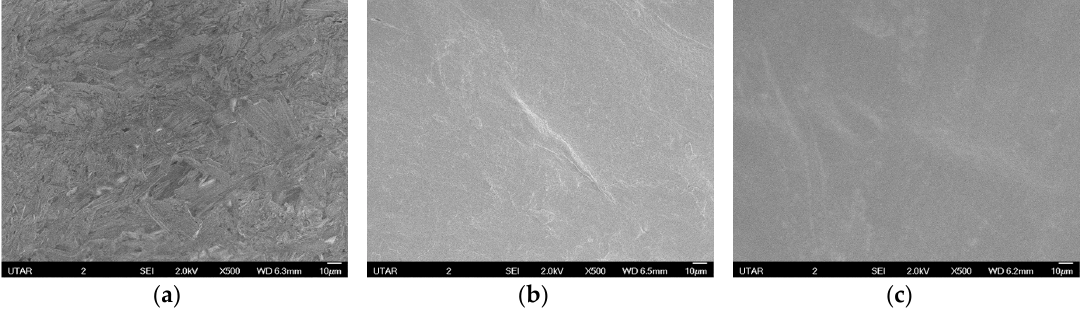
Figure 7. Scanning electron microscope (SEM) photographs of PCM (MA/PMMA, 60/40 wt %): ( a ) without coating; ( b ) with conformal coating and ( c ) with polyacrylic coating.